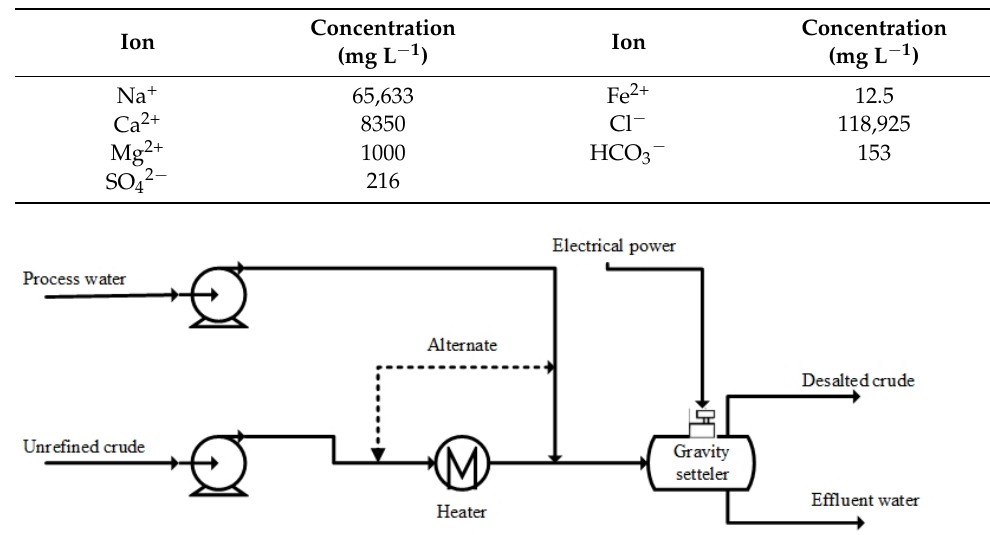
Figure 1. Schematic diagram of an electrostatic desalting unit.